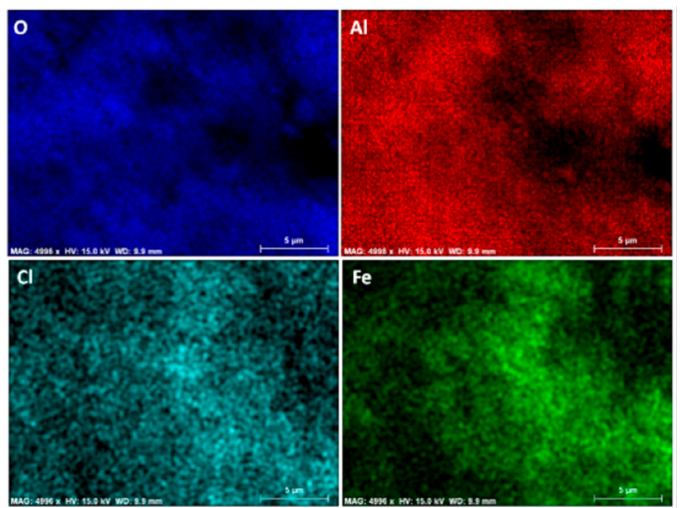
Figure 1. Mapping of the elemental distributions in sample FeAl (oxygen, aluminum, chloride, and iron) by Energy Dispersive X-ray spectroscopy (EDX) chemical analyses.